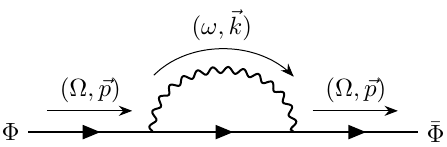
Figure 4 . Supergraph contributing to the one-loop corrections to the self-energy of the chiral